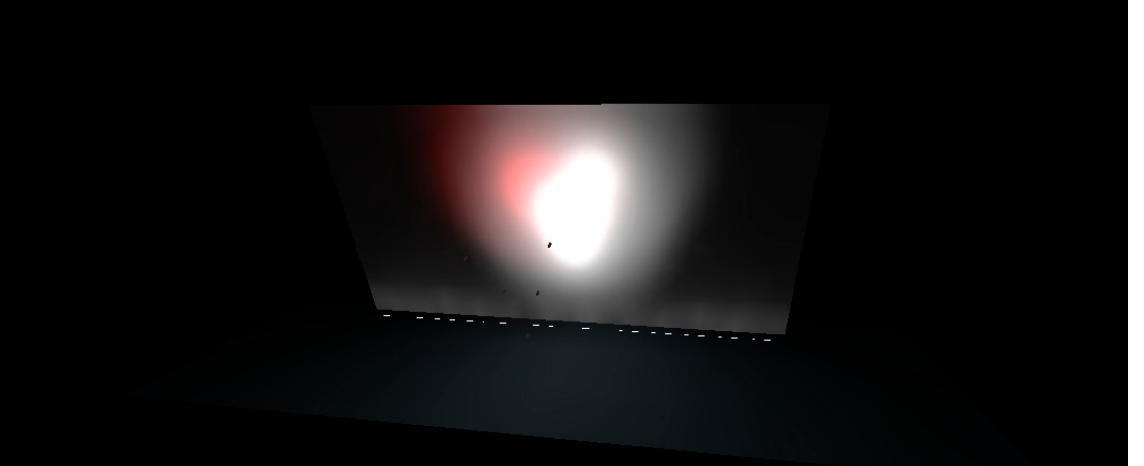
Figure 10. Simulation of visual result of Working Diagram I—Scene 3.